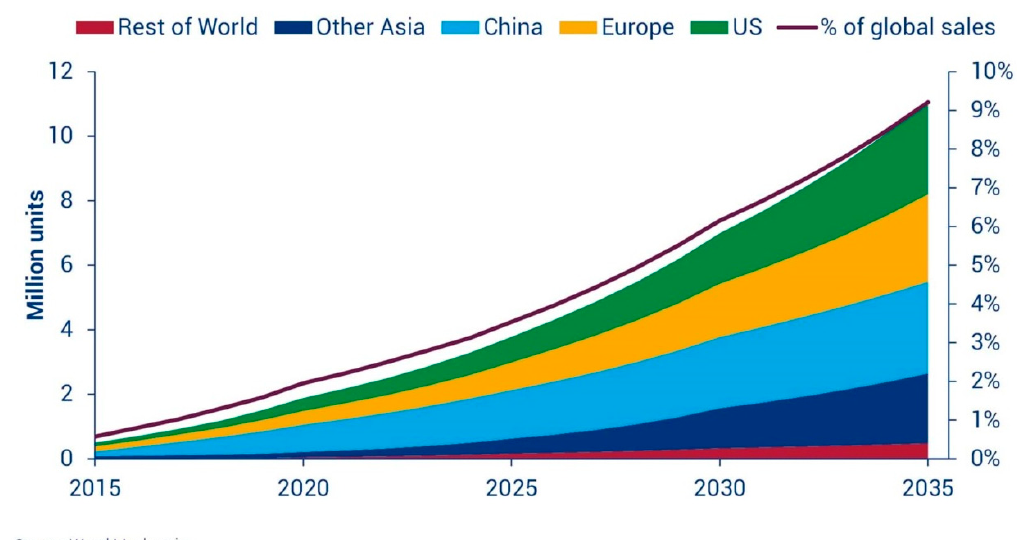
Figure 2. The dramatic growth in the electric vehicle market.